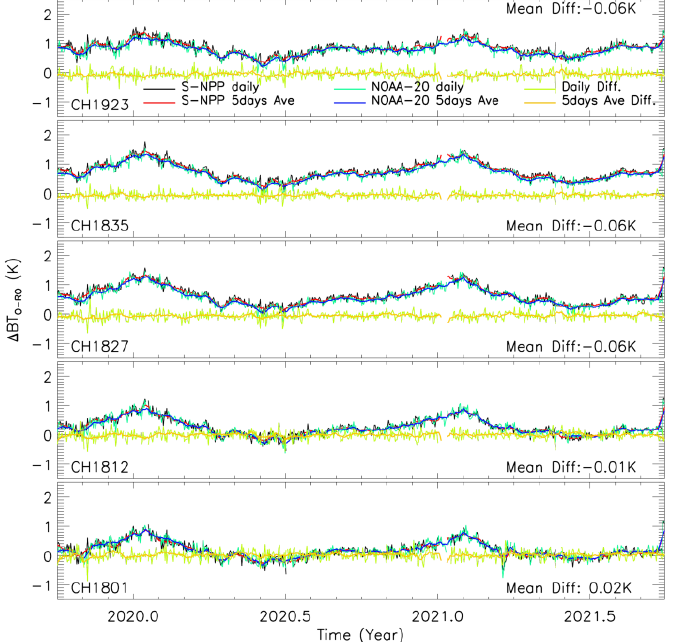
Figure 10. Same as Figure 9, except for results from the daytime.